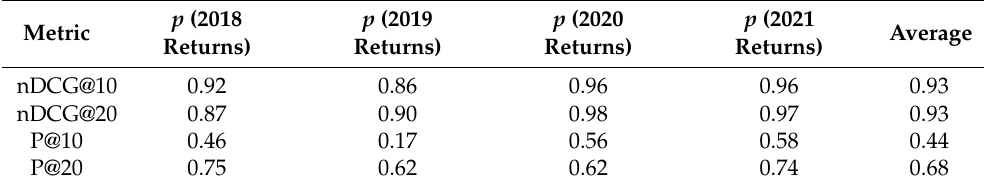
Table 11. Pearson’s correlation coefficients ( p ) between models’ returns and models’ performances (using both nDCG and P) are estimated for the years 2018, 2019, 2020, and 2021. p (2018 Metric